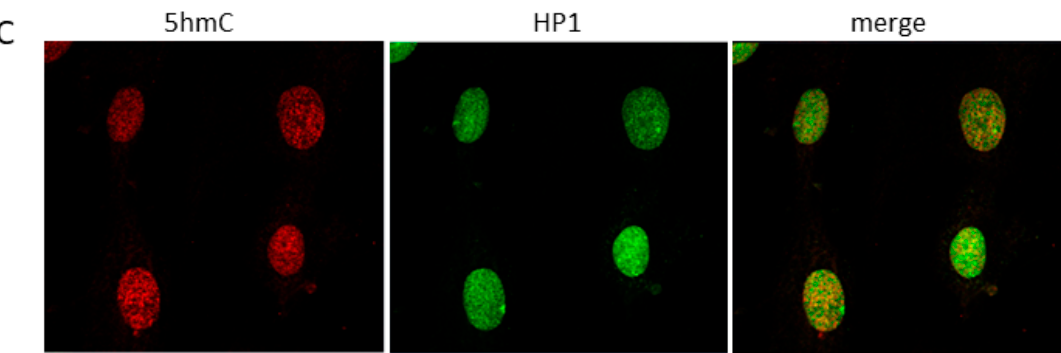
Figure 3. Immunofluorescence staining for the presence of 5-methylcytosine (5mC), 5-hydroxymethylcytosine (5hmC), and heterochromatin markers in human fibroblasts. ( A ) Immunostaining for the presence of 5mC and 5hmC. ( B ) Co-localization of 5hmC and MacroH2A histone variant. ( C ) Co-localization of 5hmC and heterochromatin protein 1 (HP1).